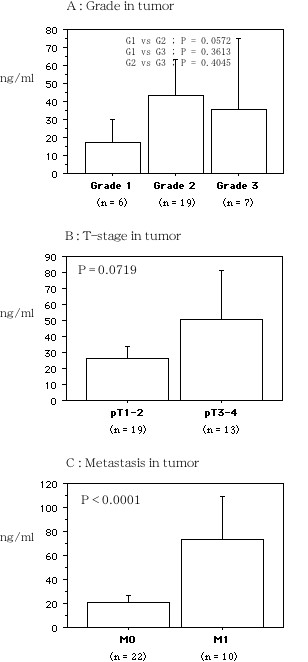
Serum hepcidin-25 concentration in the patients with renal cancers. A; In Grade 1 to 3 tumors. B; In pT1–2 and pT3–4 tumors. C: In metastasis (+ : 1) and (- : 0). The data show the 95% confidential interval.